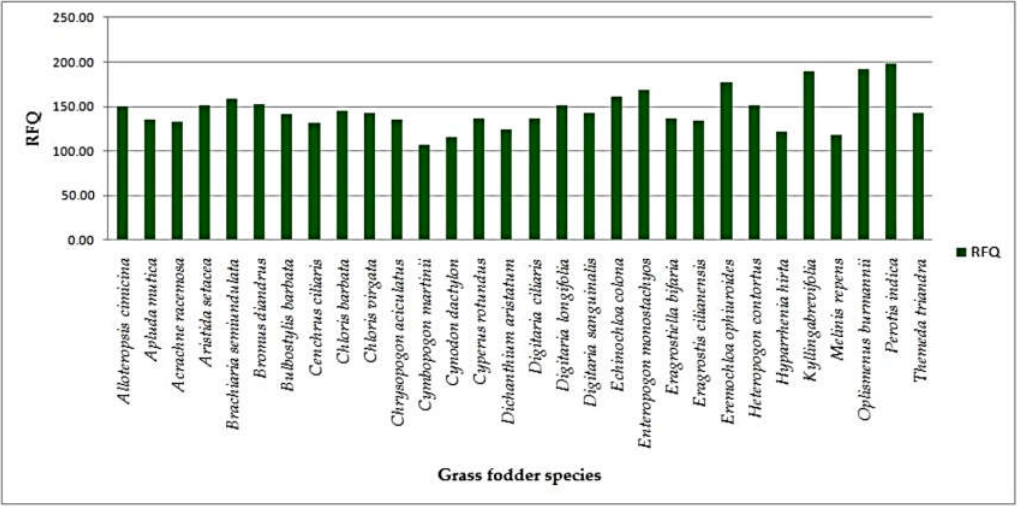
Figure 5. Relative forage quality of native grass fodder species.